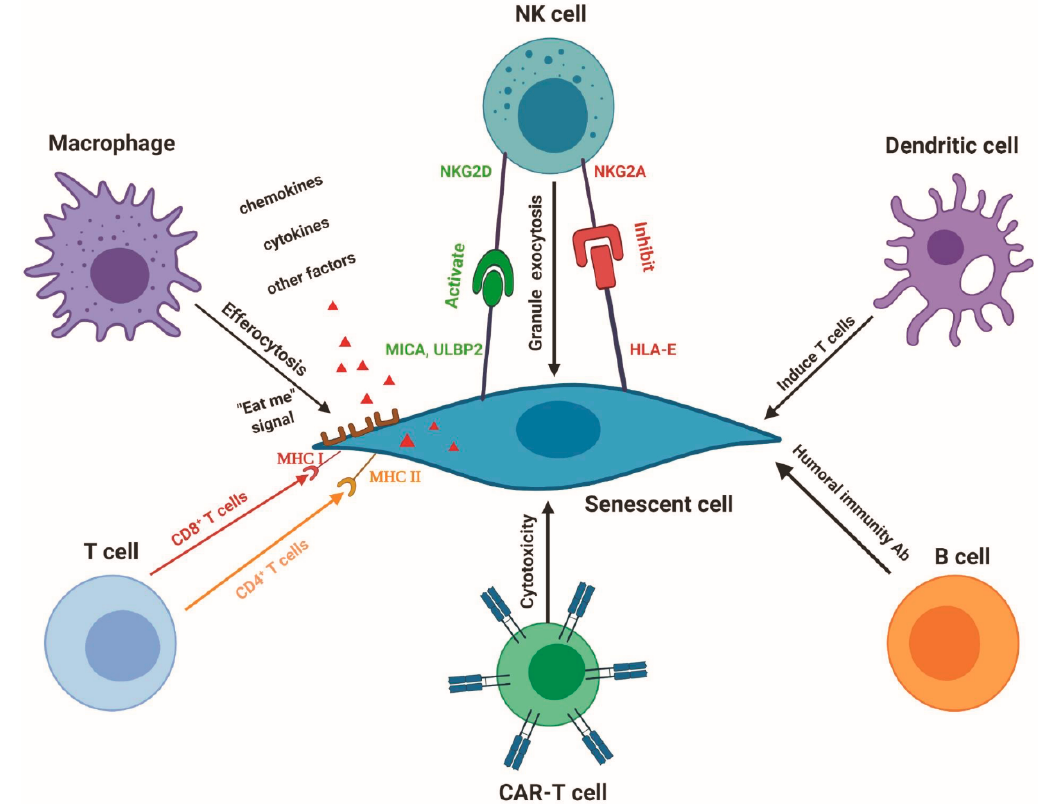
Figure 1. Senescent cell elimination by the immune system. Different senescent cells generate distinct ligands, including MICA/B, ULBP2, MHC I, MHC II and HLA-E. Individual immune cells, including macrophages, NK cells, T cells, CAR-T cells and dendritic cells, can precisely recognize the senescent cells via these ligands and targeted eradicate senescent cells. B cells may attack senescent cells through a humoral immunity antibody.